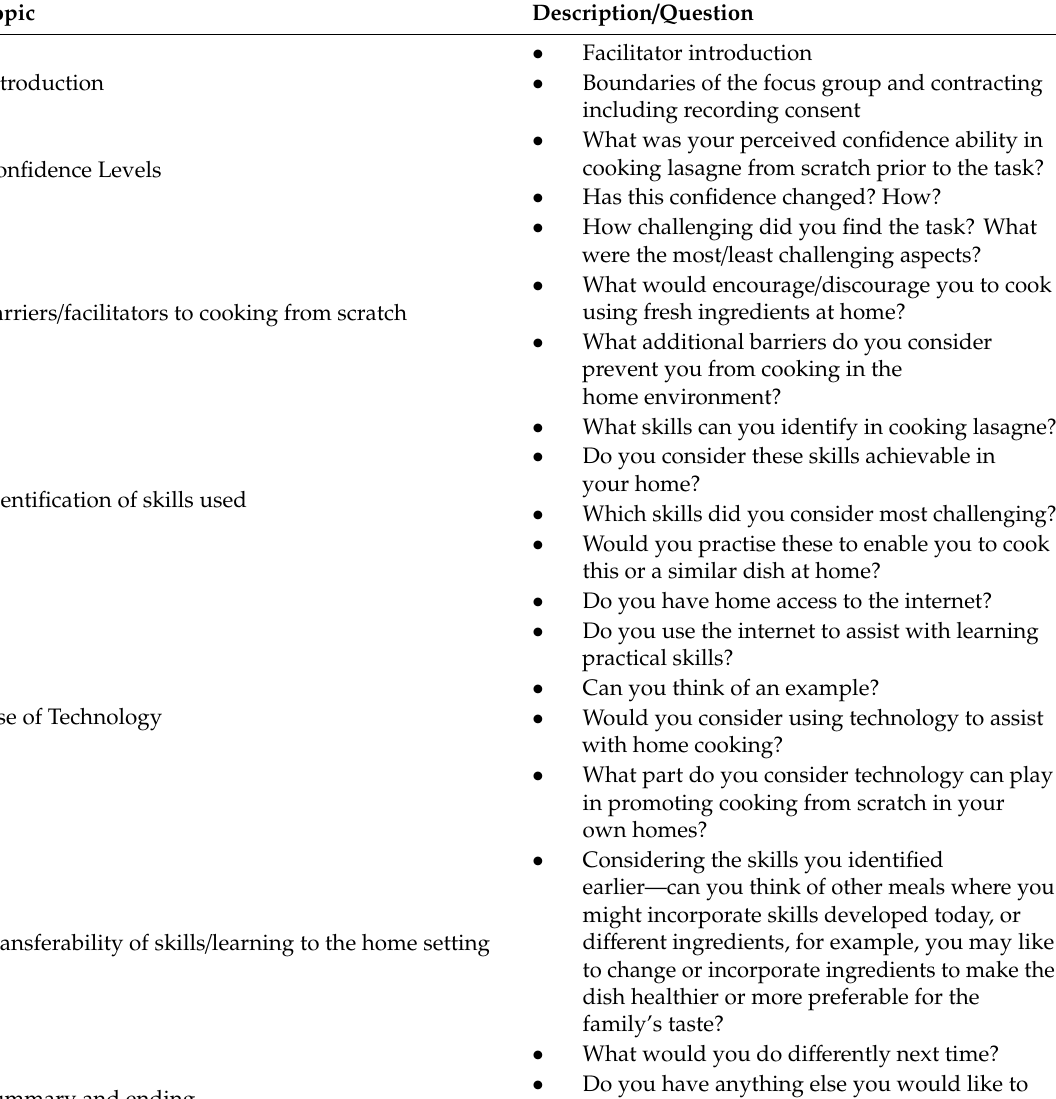
Table 1. Outline of the focus group topic